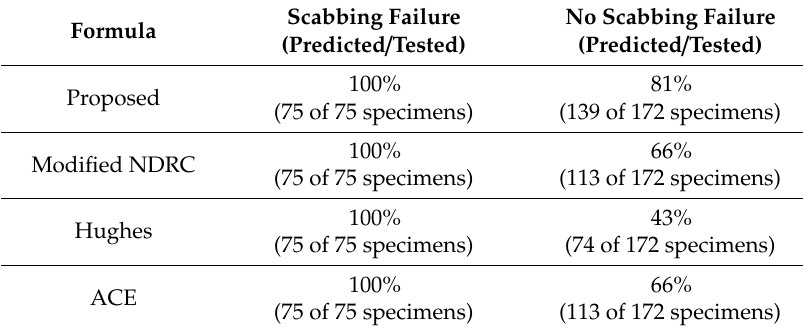
Table 2. Accuracy of scabbing limit thickness